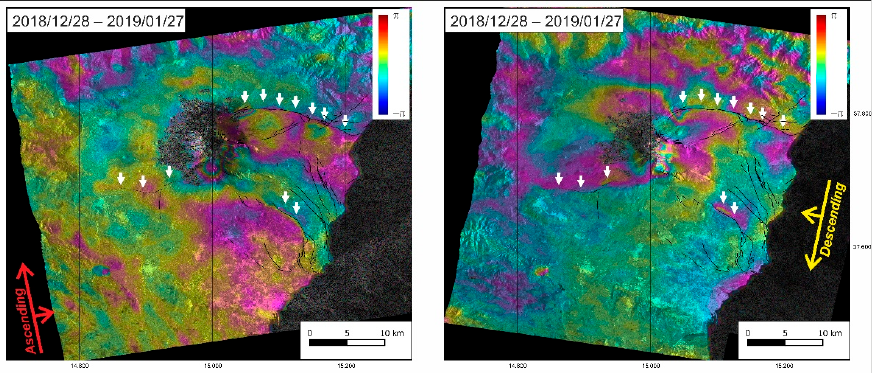
Figure 12. Ascending/descending interferogram from 28 December 2018 to 27 January 2019. White arrows indicate the fault lines bounding the ground deformation features